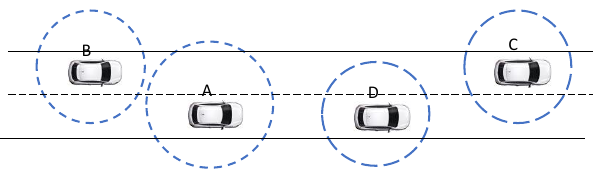
Figure 3. Initial screens of the independent Connected Mobile Virtual Fence (CMVF) clients in the four vehicles.